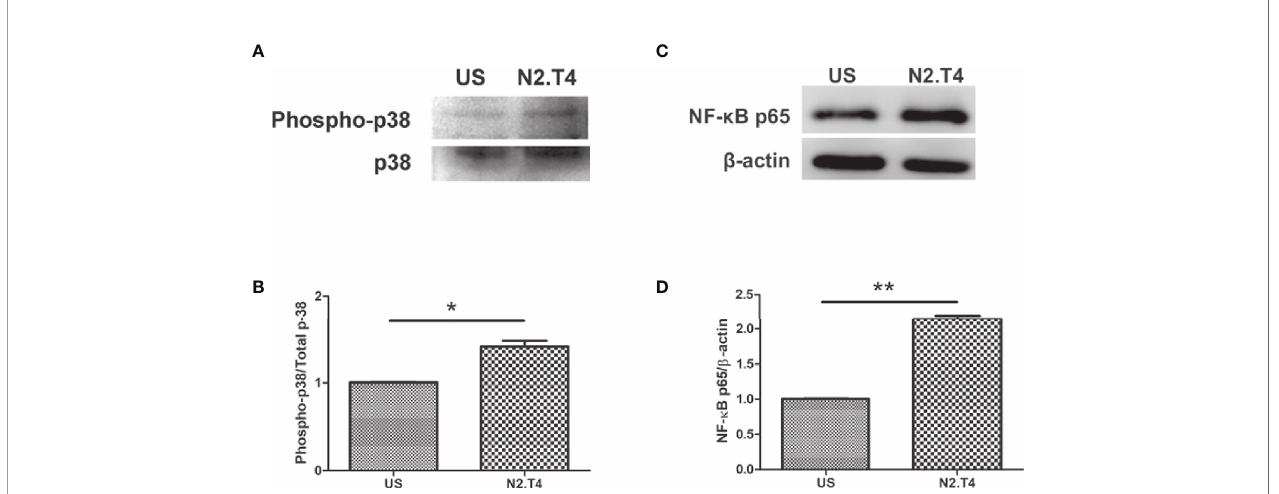
FIGURE 6 | Stimulation of MSCs through N2.T4 induced NF- k B activity via the p38 MAPK pathway. MSCs were stimulated with the ligands of N2.T4 for 24 hours and control cells were left unstimulated (US). The cells were lysed with a RIPA buffer containing protease inhibitor cocktail. Total cell lysates were subjected to SDS- PAGE and Western blotting. The blots were probed with antibodies against (A) phosphor-p38/p38 and (C) NF- k B-p65 with densitometric analysis normalized with b -actin, represented in graphs (B, D) , respectively. The data shown are representative of two independent experiments. *p < 0.05, **p < 0.01.